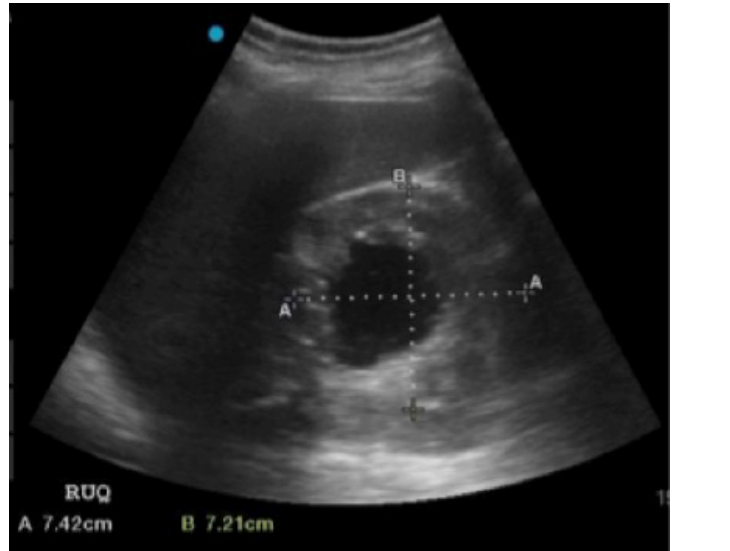
Image 2. Right upper quadrant mass seen on emergency physician-performed point-of-care ultrasound. Measurements showing 7.42 x 7.21 cm in cephalad-caudal and lateral dimensions, respectively.